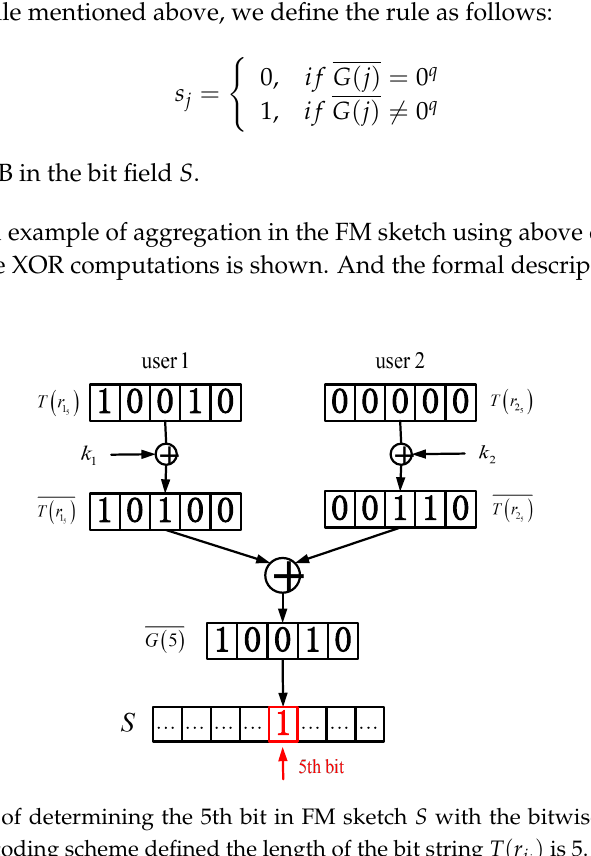
) is 5. The result shows that j